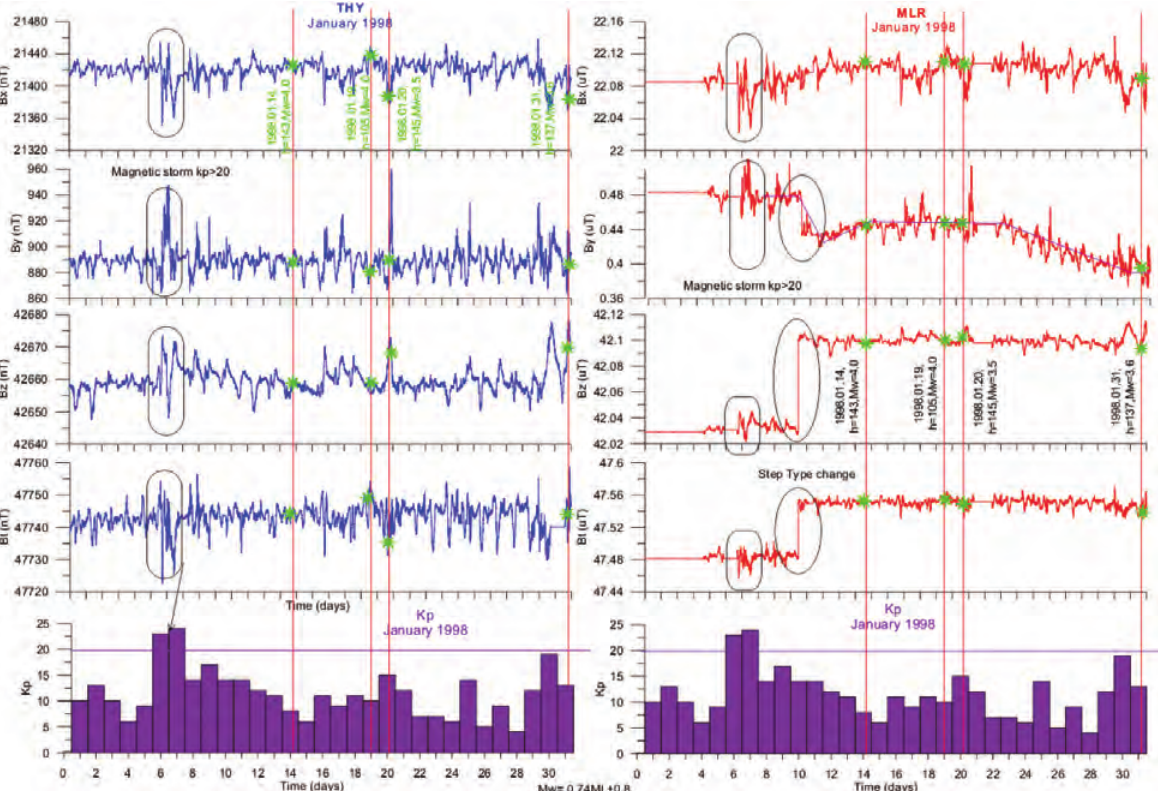
Figure 3. Kp indices of January 6, 7, 1998, reveal a magnetic storm. Two days later, on January 10, 1998, a step-change of Bz and By occurred. The By component developed a V-shaped anomaly with a duration of 4 days. An earthquake with magnitude Mw 4.0 (h = 143 km) occurred at the end of this anomaly.